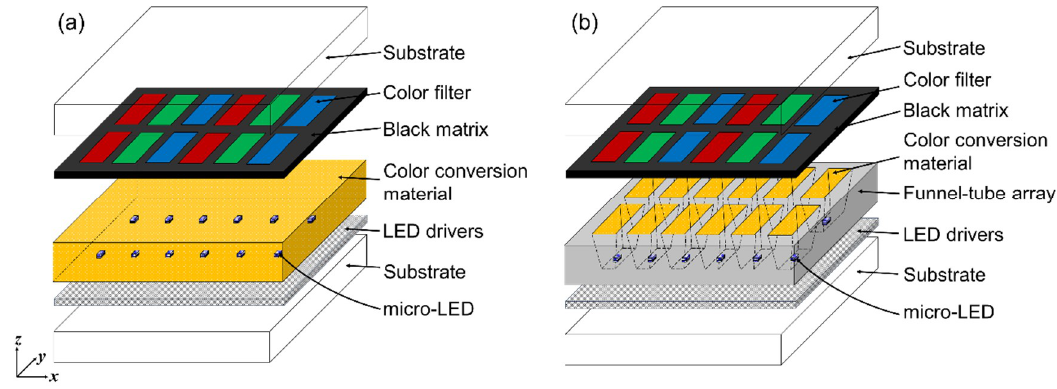
Figure 1. Schematic diagram for configuration of full color micro-LED display ( a ) device A: without funnel-tube array, and ( b ) device B: with funnel tube array.